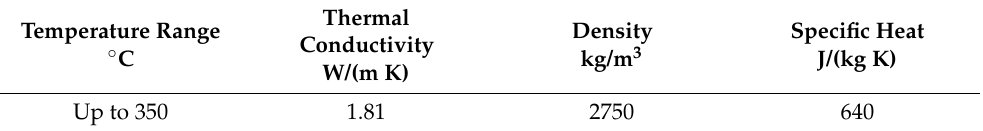
Table 3. The main parameters of the “akubet” material used in the tested SAH.